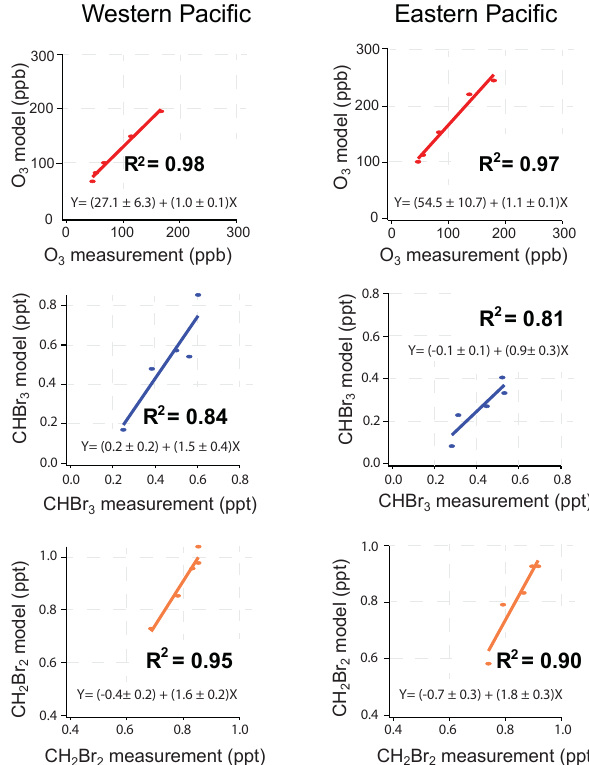
Figure 3. Correlations between measured and modeled mixing ra- tios of O 3 , CHBr 3 , and CH 2 Br 2 over the WP and EP, using 1km average bins. Filled circles are the mixing ratios averaged into 1km altitude bins (same as in Fig. 1 for O 3 , and Fig. 1 in Navarro et al., 2015, for CHBr 3 and CH 2 Br 2 ) . Solid lines represent the linear re- gression analysis of the 1km average bins including the coefficient of determination ( R 2 ) and regression equation ( Y